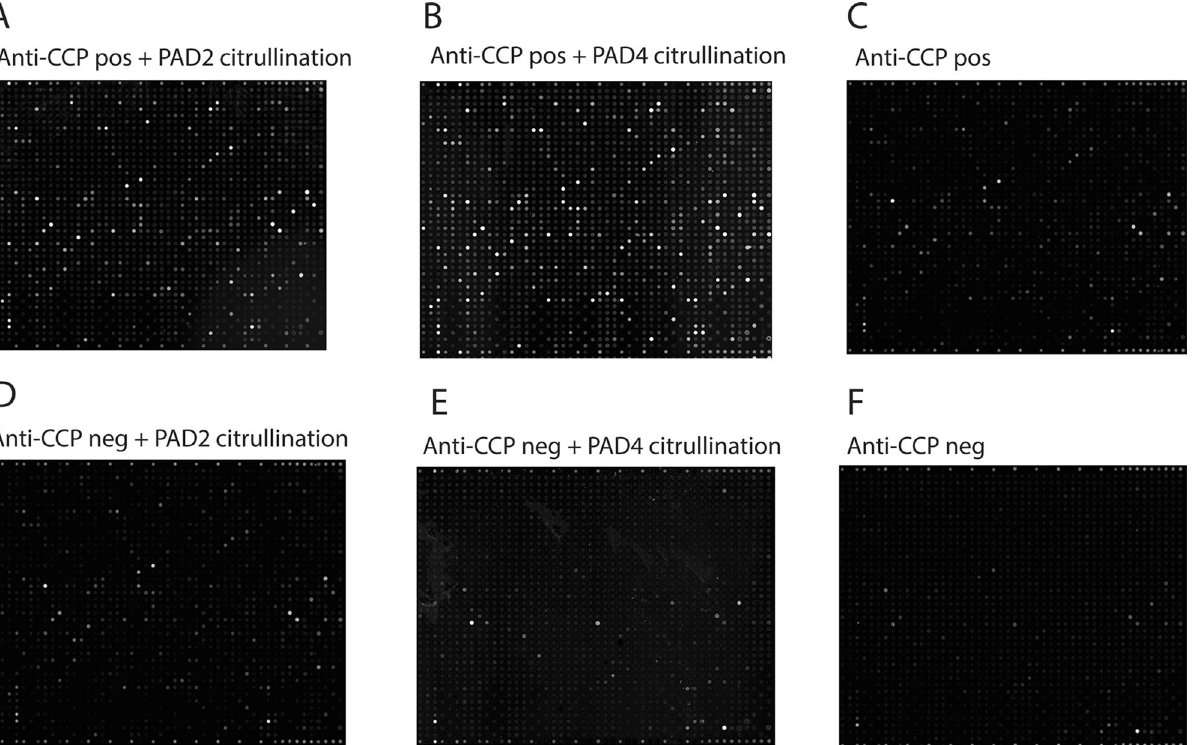
Figure 1. Imaging of autoantibody binding to citrullinated and non-citrullinated protein arrays. Pooled plasma from 15 anti-CCP-positive RA patients or 10 anti-CCP-negative RA patients was diluted 1:200 and added to microarray plates containing 1631 human proteins that had been citrullinated by PAD2 or PAD4 or kept in native form. The binding of IgG antibodies was visualized using Cy3-labelled rabbit anti-human IgG antibodies. ( A ) Slide with proteins citrullinated by PAD2 and incubated with anti-CCP-positive plasma. ( B ) Proteins citrullinated by PAD4 incubated with anti-CCP-positive plasma. ( C ) Native proteins incubated with anti-CCP- positive plasma. ( D ) Proteins citrullinated by PAD2 incubated with anti-CCP-negative plasma. ( E ) Proteins citrullinated by PAD4 incubated with anti-CCP negative plasma ( F ) . Native proteins incubated with anti-CCP- negative plasma. ( C , F ) have previously been published 20 .